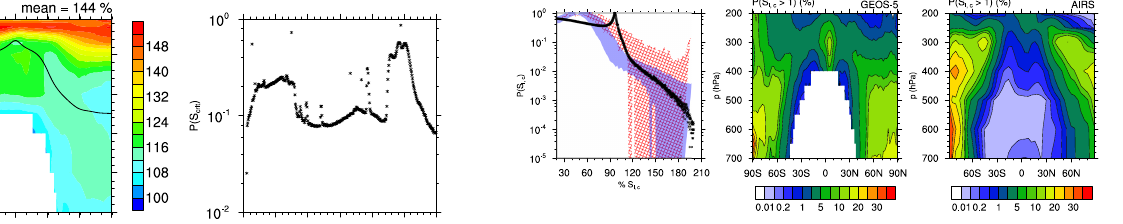
Figure 3. Global frequency distribution of clear sky saturation ratio with respect to ice obtained from 6h instantaneous GEOS-5 output over a 3-year subset (2002–2004) of the NEW run (left panel, black dots). Filled areas correspond to the frequency distributions from AIRS (solid area) satellite retrievals (Gettelman et al., 2006) and the MOZAIC (hatched area) data set (Gierens et al., 1999), respec- tively, for the years 2002–2004. Uncertainty in the observations was calculated as one standard deviation around the mean value within a 2 ◦ × 2 ◦ grid cell and introducing a 10% perturbation in S i along the x axis. The center and right panels show the zonal mean fre- quency (%) of clear sky supersaturation from GEOS-5 and AIRS,